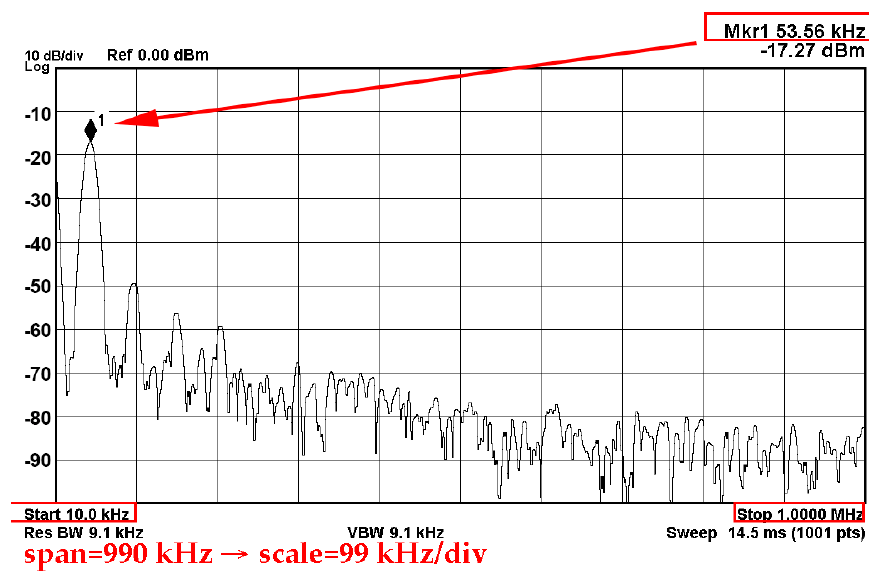
Figure 25. The experimental quadrature V o1 (blue) and V o2 (cyan) voltage waveforms.